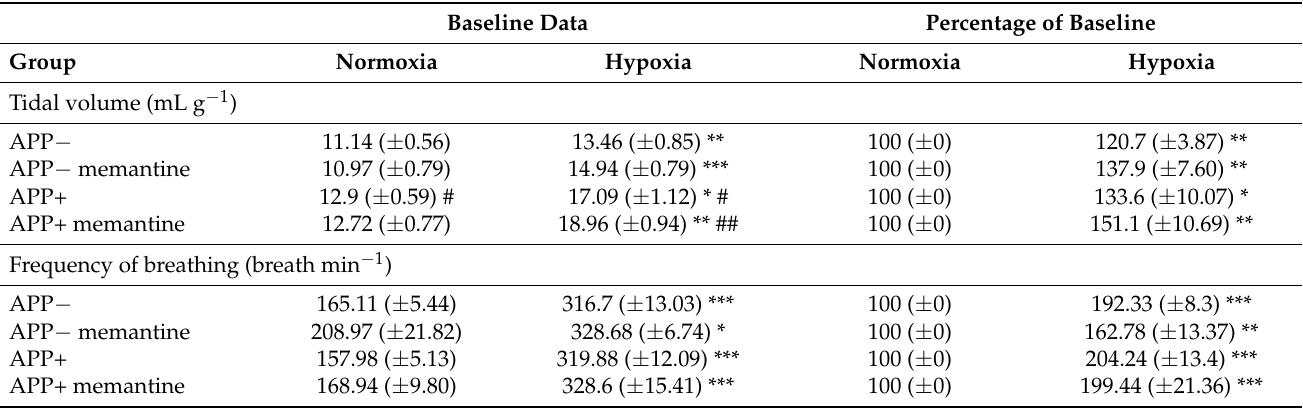
The data are presented as mean ± SEM; * p < 0.05, ** p < 0.01, *** p < 0.001 vs. baseline normoxia value. # p < 0.05, ## p < 0.01, vs. APP − value. (n = 6 for APP+ and APP − ).